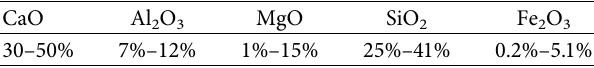
Table 1: Main components of the